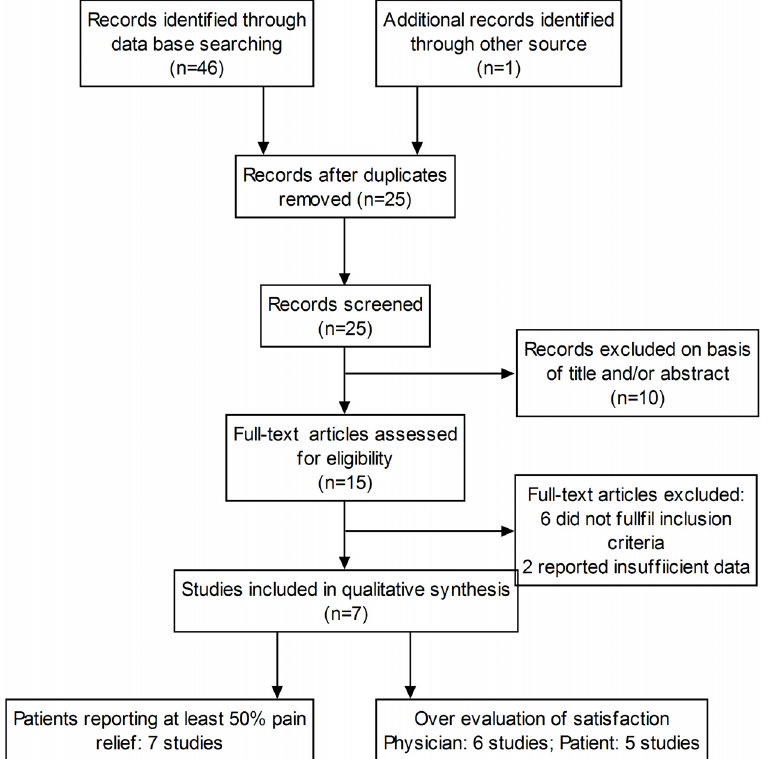
Fig 1. PRISMA flow chart detailing retrieved, excluded, assessed, and included trials.